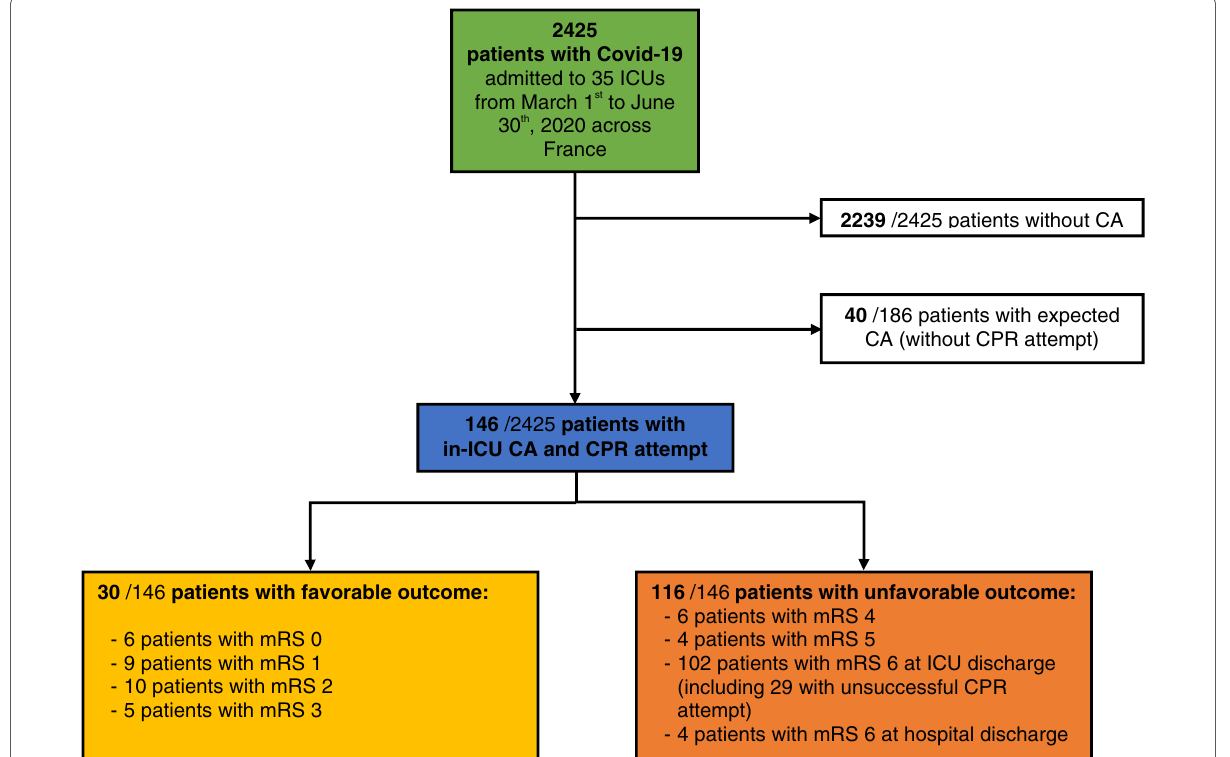
Fig. 1 Study flowchart. ICU intensive care unit, CA cardiac arrest, mRS modified Rankin